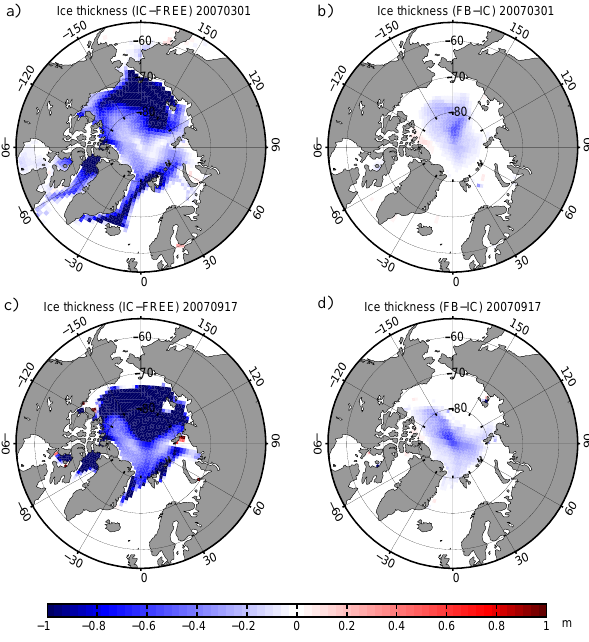
Fig. 7. Sea-ice thickness during the MA07 (March–April) campaign in the FREE, IC and FB runs ( a, b, c respectively), and in the